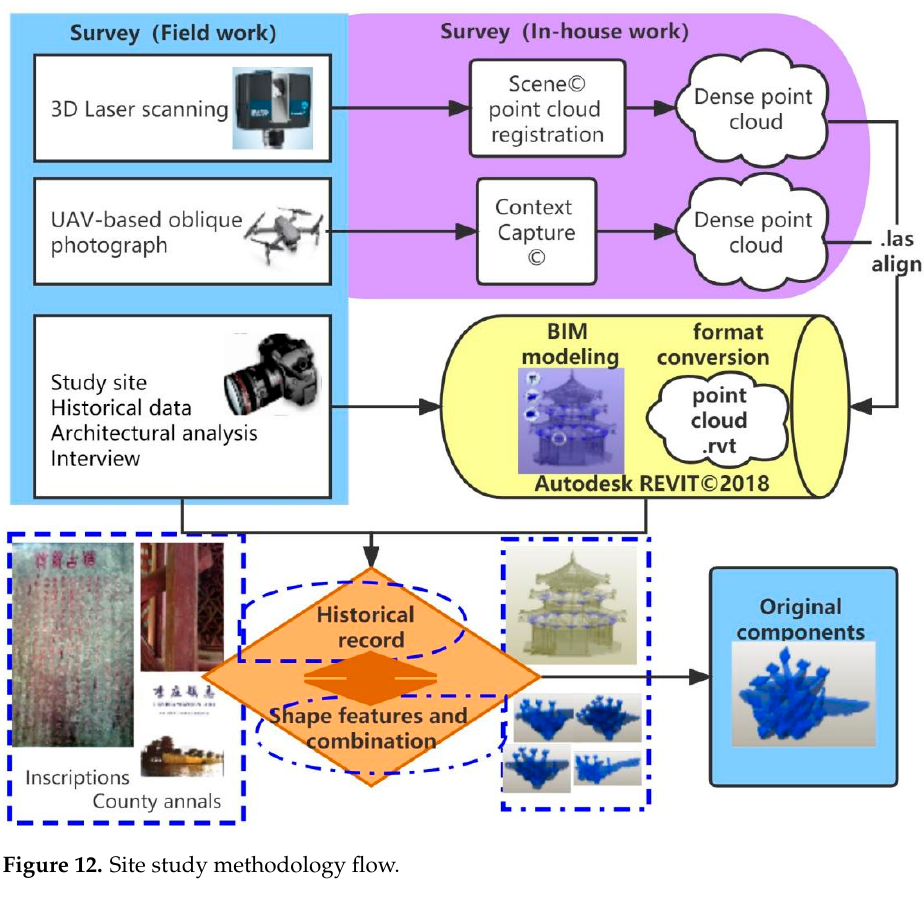
Figure 12. Site study methodology flow.